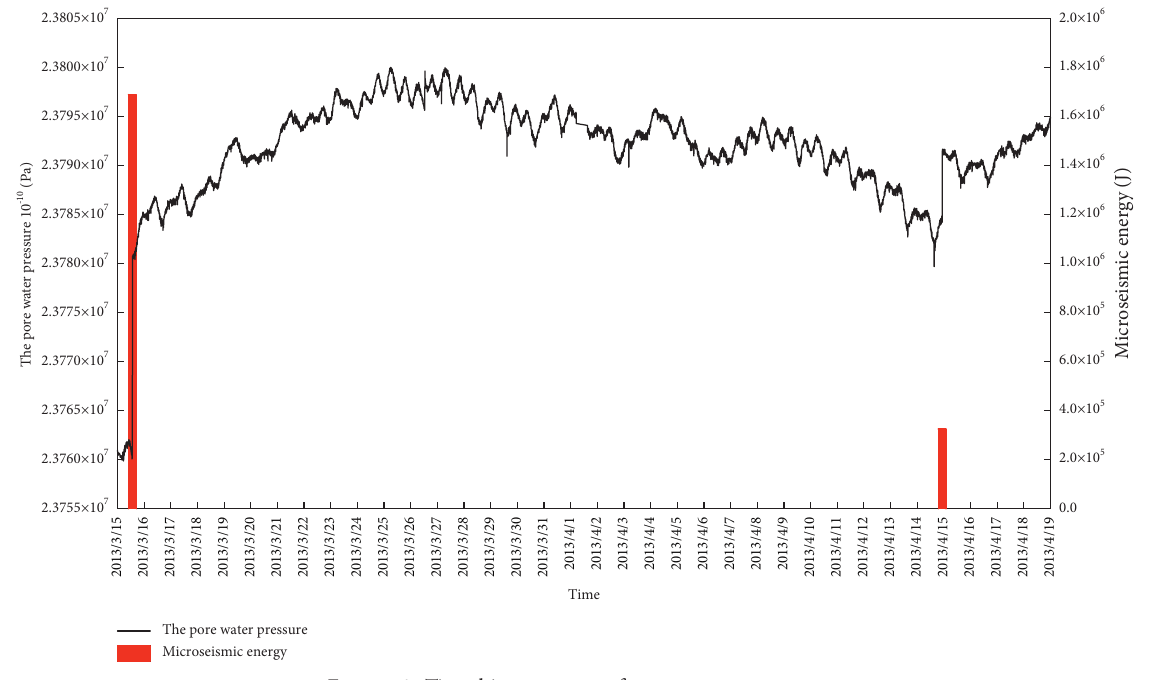
Figure 3: Time history curve of pore water Table 2: Information table of rockburst events.